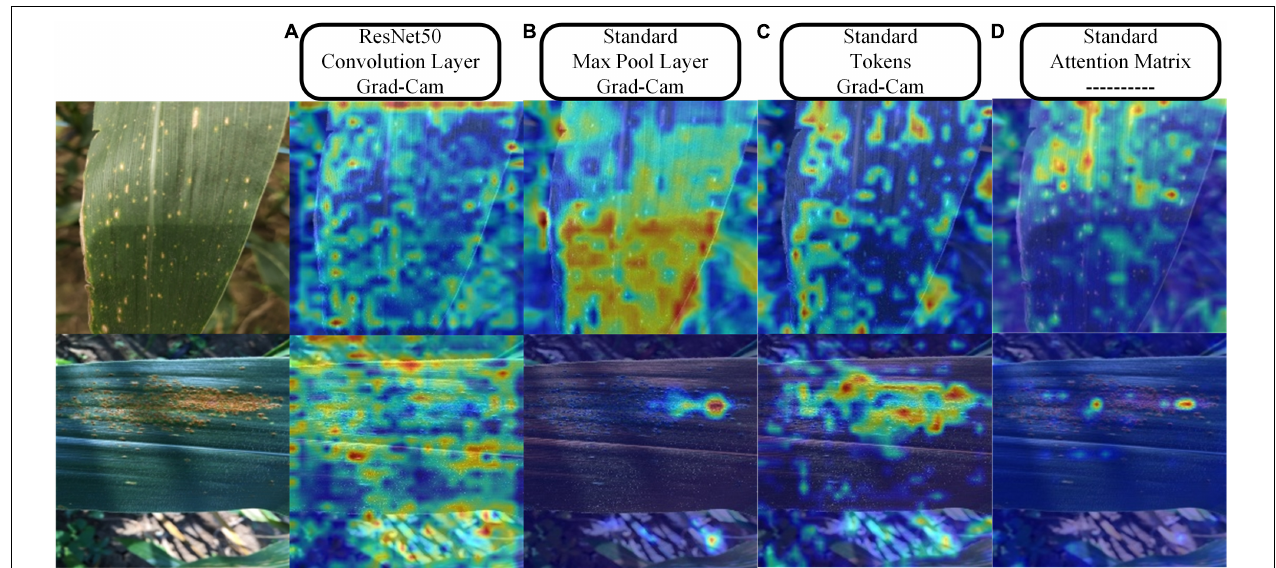
FIGURE 12 | Visualization results of the three schemes. (A) Grad-Cam method for visualization of the feature maps output by the Resnet50 convolutional layer. (B) Grad-Cam method for visualization of the feature maps output from the max-pooling layer of the standard model. (C) Grad-Cam method for visualization of the tokens of the standard model. (D) Directly map the attention of the classification token on feature tokens to the original image.